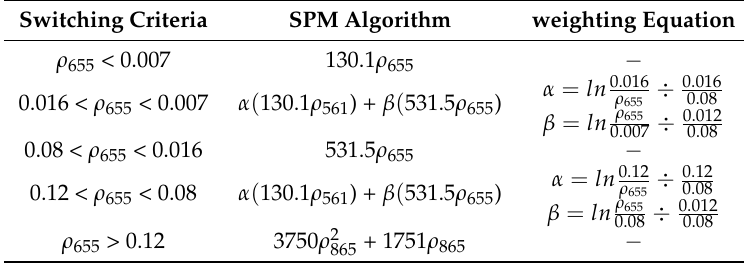
Table 5. Novoa17 swithcing